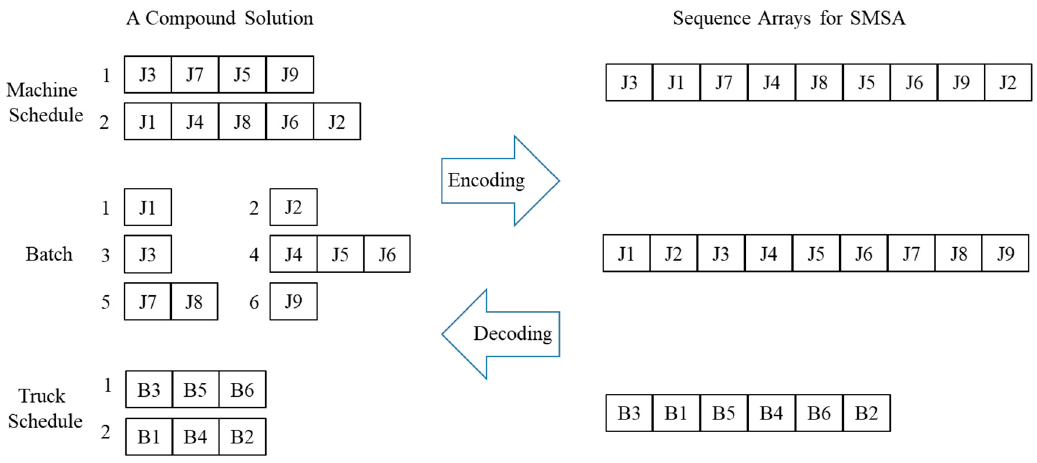
Figure 3. Encoding and decoding procedures.